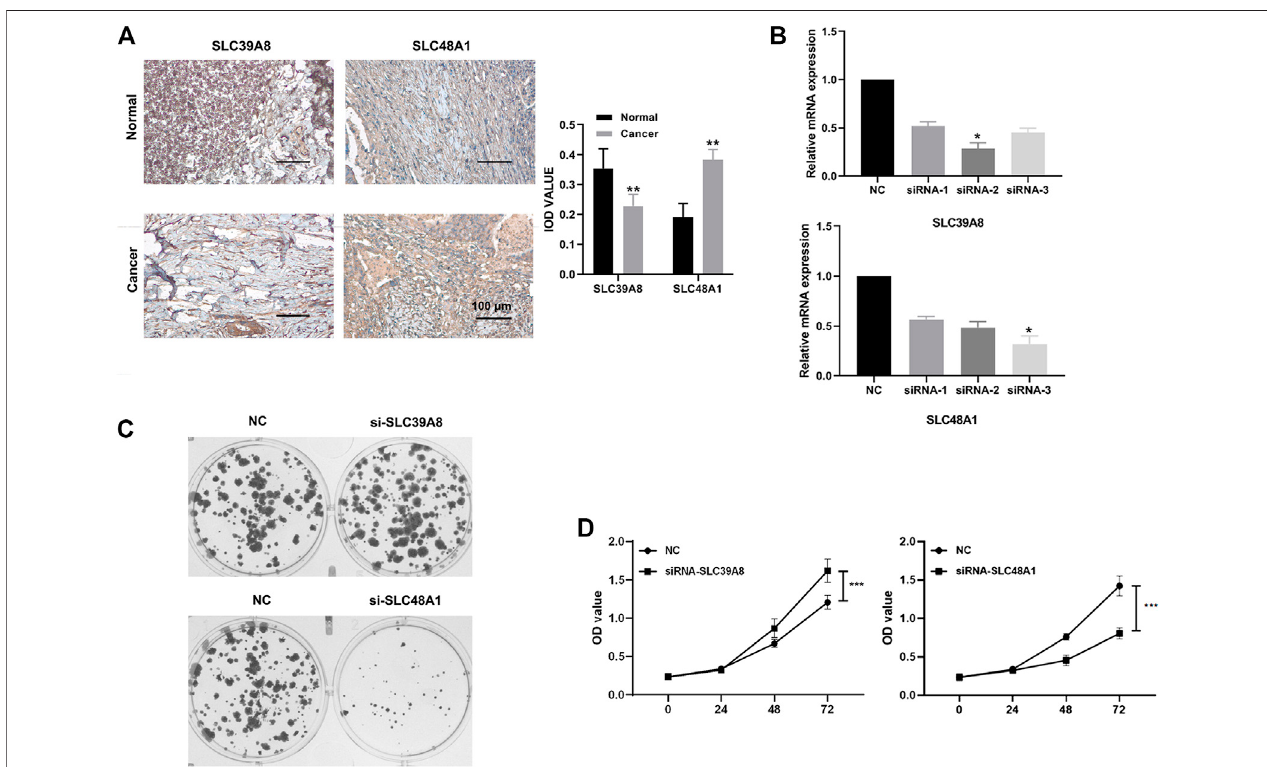
FIGURE8| Expressionveri fi cationandfunctionalanalysisofgenesrelatedtoironmetabolism. (A) ImmunohistochemicalresultsshowedthatSLC48A1washighly expressed in human colon cancer tissues, while SLC39A8 was low expressed in human colon cancer tissues. (B) mRNA levels of SLC39A8 and SLC48A1 were knocked down using siRNAs in colon cancer cells. The results of cell clonal formation assay (C) and MTS (D) showed that knockdown SLC48A1 inhibited the proliferationofDLD1cells,while knockdown SLC39A8promotedtheproliferationofDLD1cells. Dataareshownasmean ± SD;* p < 0.05,*** p < 0.001(versusNC